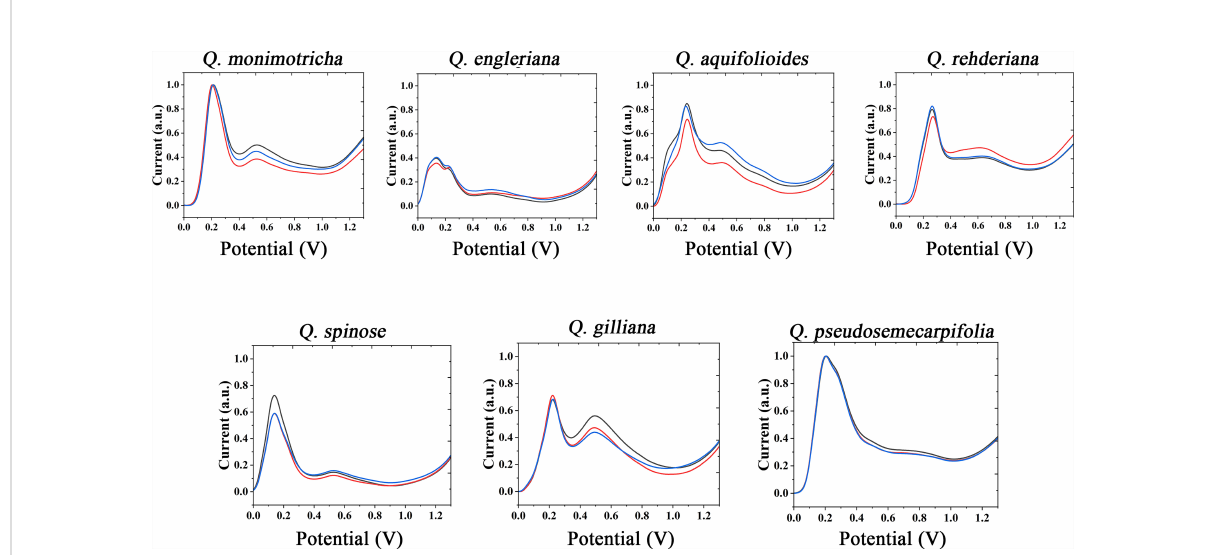
FIGURE 2 Electrochemical fi ngerprint of Q. monimotricha, Q. engleriana, Q. aquifolioides, Q. rehderiana, Q. spinosa, Q. gilliana and Q. pseudosemecarpifolia after ethanol extraction and recorded under ABS condition with three repetitive